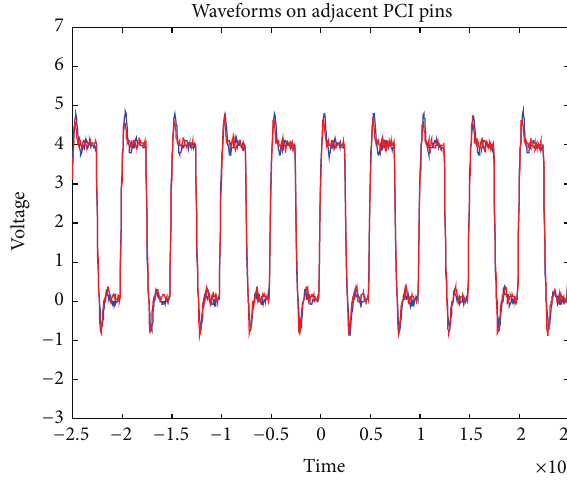
Figure 13: No. 1 SI test on PCI pins.